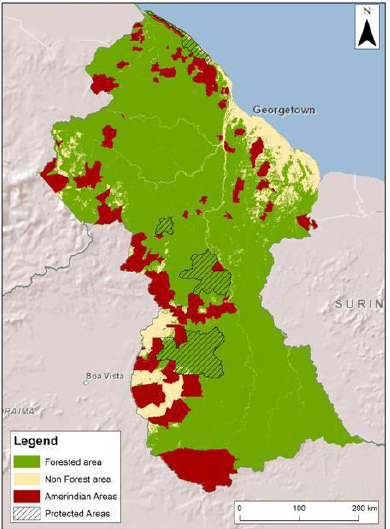
Figure 1: Land classes of